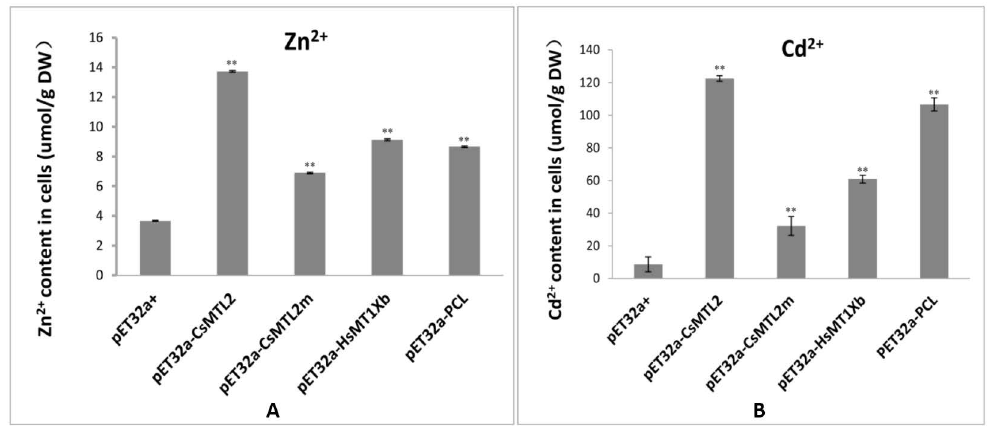
Figure 5. Metal ion accumulation in transgenic E. coli . Comparison of zinc (Zn) and cadmium (Cd) ion accumulation after 3 h of Zn 2+ ( A ) and Cd 2+ ( B ) ion treatment in E. coli cells heterologously expressing CsMTL2, CsMTL2m, HsMTXb, and PCL. The error bars represent standard errors of the mean from at least three independent experiments. Statistical significance was based on a Student’s t -test ** : p < 0.01. DW: dry